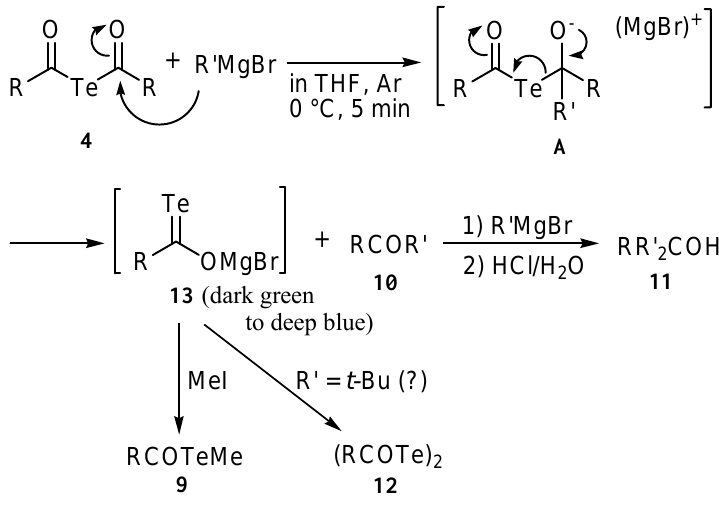
Scheme 3. A possible mechanism for the reactions of (2-MeOC Grignard